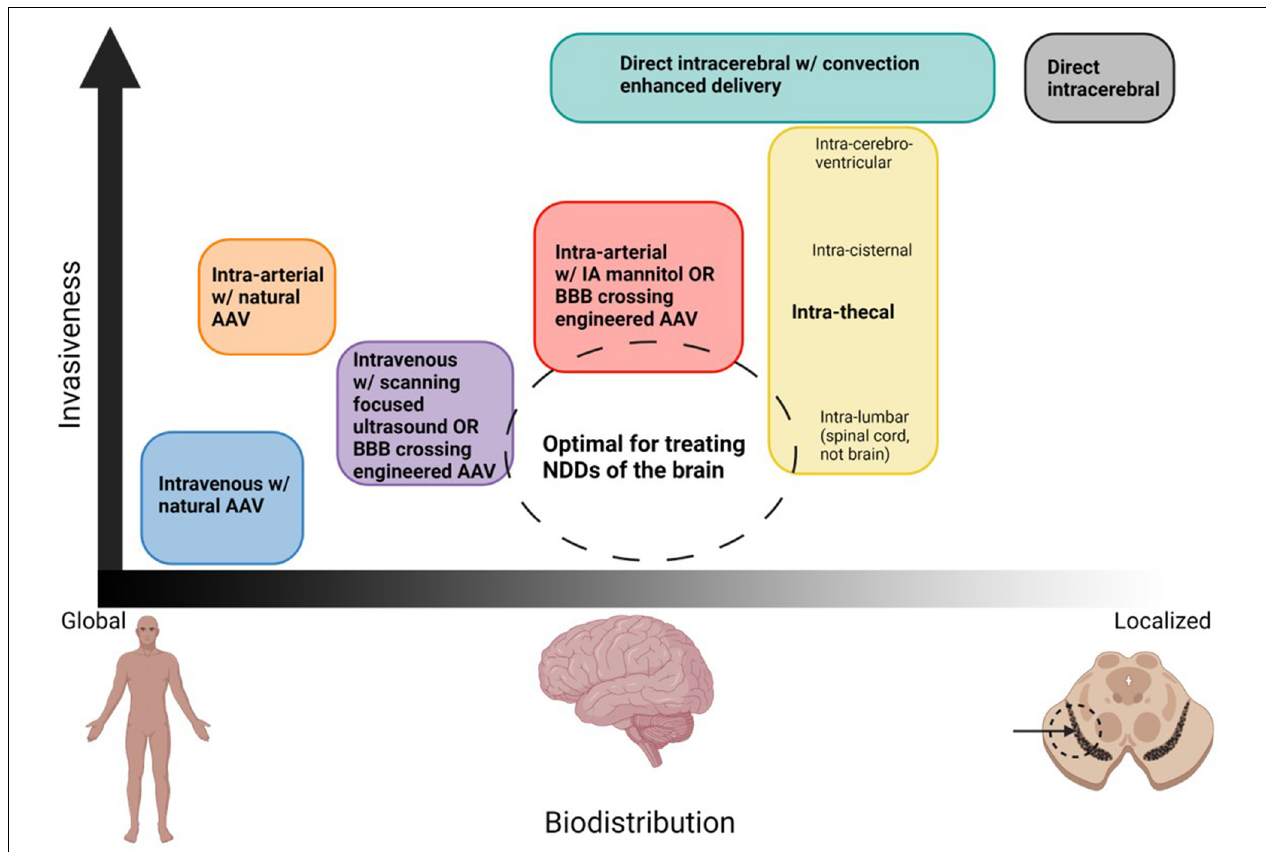
FIGURE 3 | Organization of potential routes of AAV delivery based on biodistribution and invasiveness. Ideal routes for the treatment of NDDs would transduce the entire brain but minimize systemic delivery, and would the least invasive possible. The dashed circle denotes where this ideal treatment would lie. Although no delivery method is perfect, the closest would be intravenous or infra-arterial with a strategy to cross the BBB which works in humans, intra-cisternal or intra-lumbar for spinal cord diseases. Created with